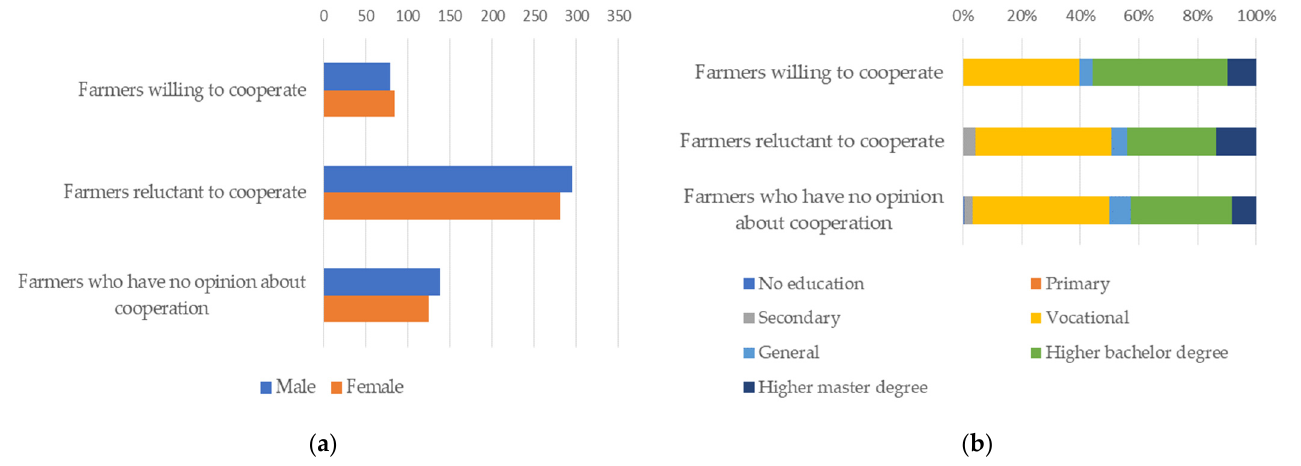
Figure 6. Distribution of smallholder farmers according to their gender ( a ) and the level of education ( b ) (N = 1002).